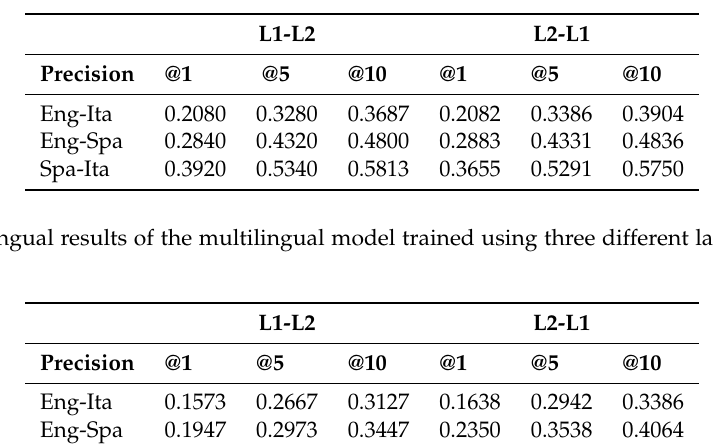
Table 12. Results of bilingual models trained pairwise on the three different languages.